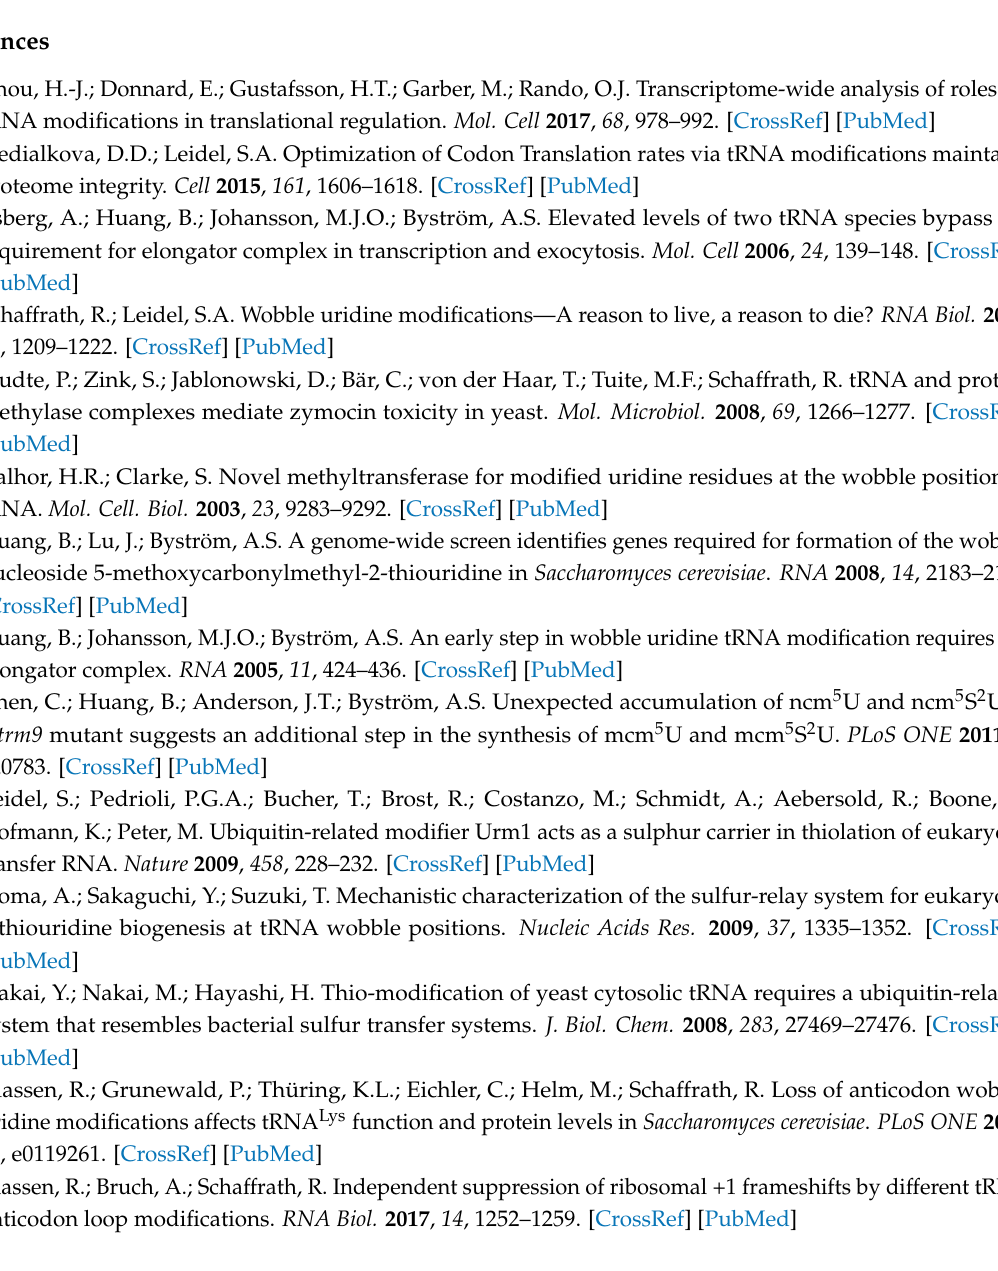
Table S1: Gene ontology analysis of protein aggregates identified by mass spectrometry from tRNA modification mutant ncs2 elp6 § . § Cell compartment assignment of proteins identified in aggregates from modification mutant ncs2 elp6 by quantitative mass spectrometry [2] was analyzed with the gene ontology (GO) term function [47] of Saccharomyces genome database (SGD) [48]. Author Contributions: Conceptualization, A.B., R.K. and R.S.; investigation, A.B.; writing—original draft preparation, A.B., R.K. and R.S.; writing—review and editing, A.B., R.K. and R.S.; funding acquisition, R.K. and